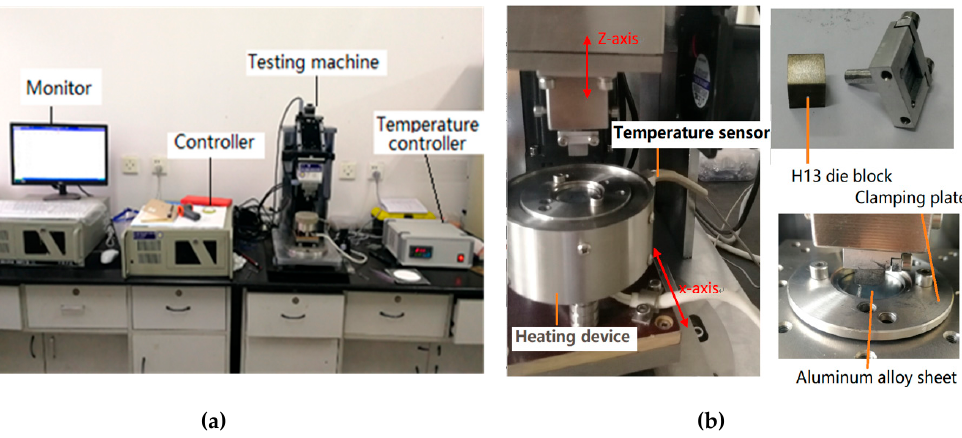
Figure 2. CFT-I multifunctional material surface comprehensive performance tester. ( a ) Disk–pin friction test principle; ( b ) Temperature control table.